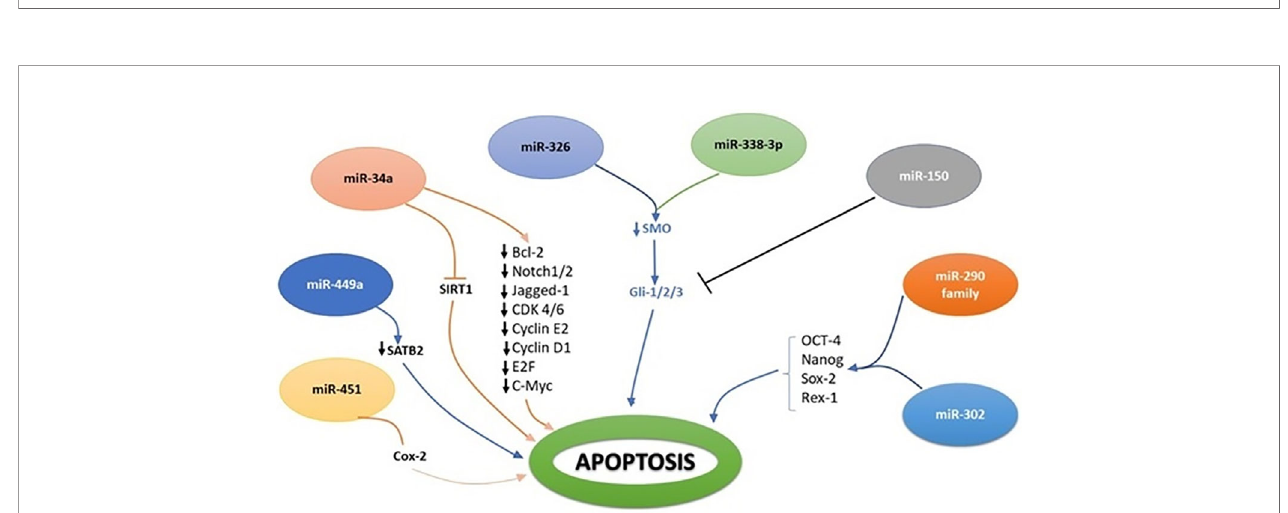
FIGURE 2 | miRNAs targeting SMO oncogenic hedgehog pathway to induce apoptosis in CRC.